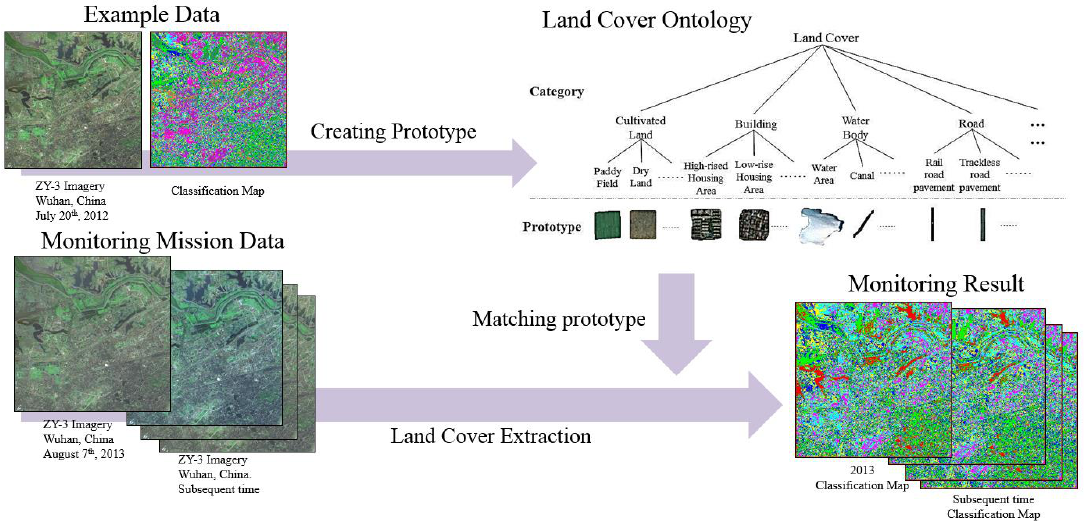
Figure 4. Procedure of using ontology and prototype in land cover extraction. With the help of prototype, which is created from the example data, the data ranges of features are inputted into the extraction procedure, and then automatic land cover extraction for subsequent image can be done.